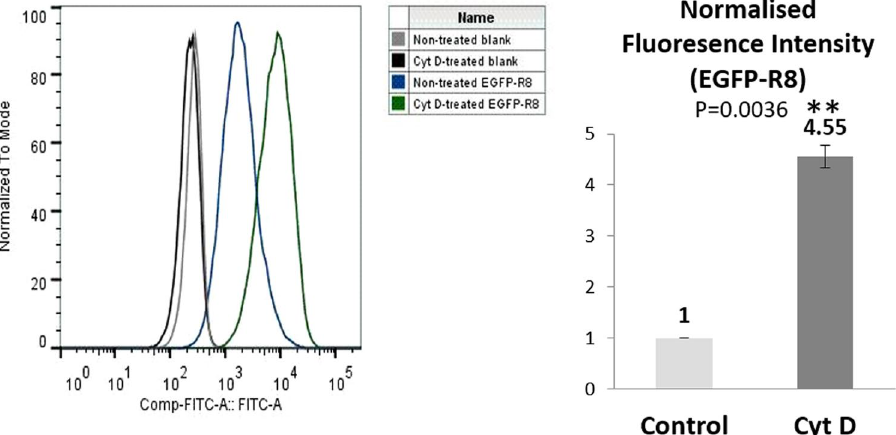
Figure 2. Cytochalasin D treatment increases the cellular uptake of EGFP-R8 in A431 cells. Cells were preincubated with 10 µ M Cyt D or diluent control for 15 min prior to incubation with 2 µ M EGFP-R8 in the absence or presence of 10 µ M Cyt D for 1 hr. Cells were then washed, trypsinised and analysed by flow cytometry. Data represent the geometric means ± S.D. from three independent